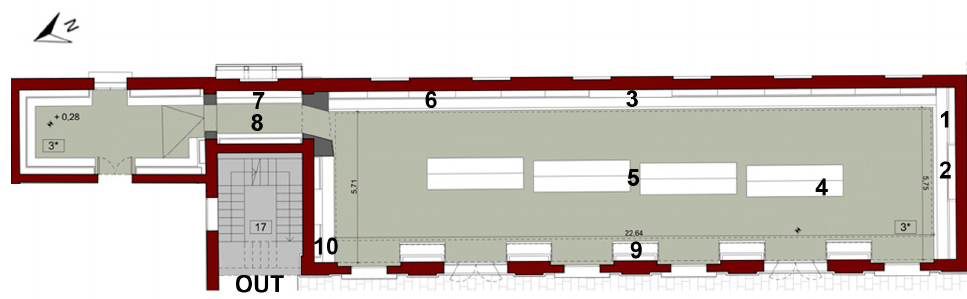
Figure 3. Map of the Hall of Palms with the positions of the sensors (courtesy of Arch. G. Mar).